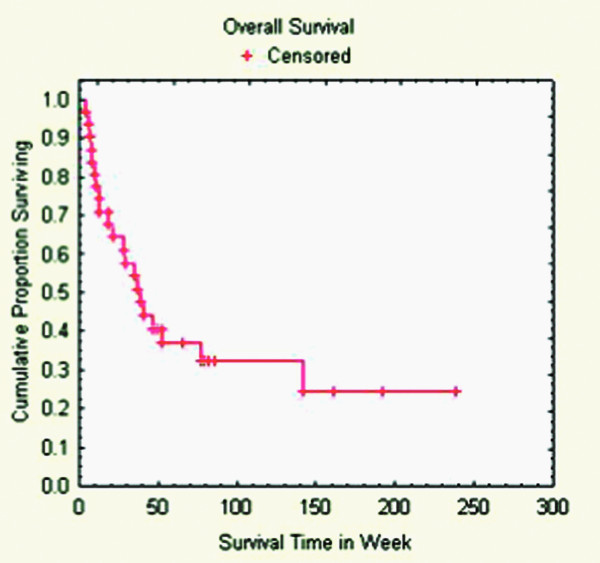
Overall survival.